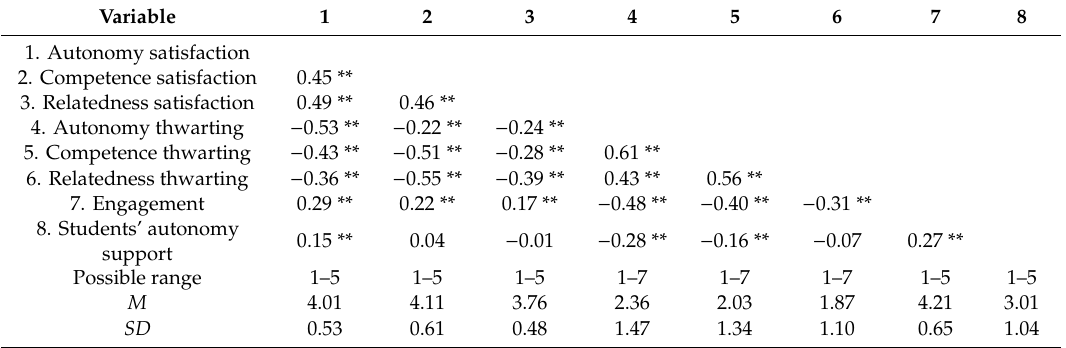
Table 1. Descriptive statistics, between-level and within-level correlations between study